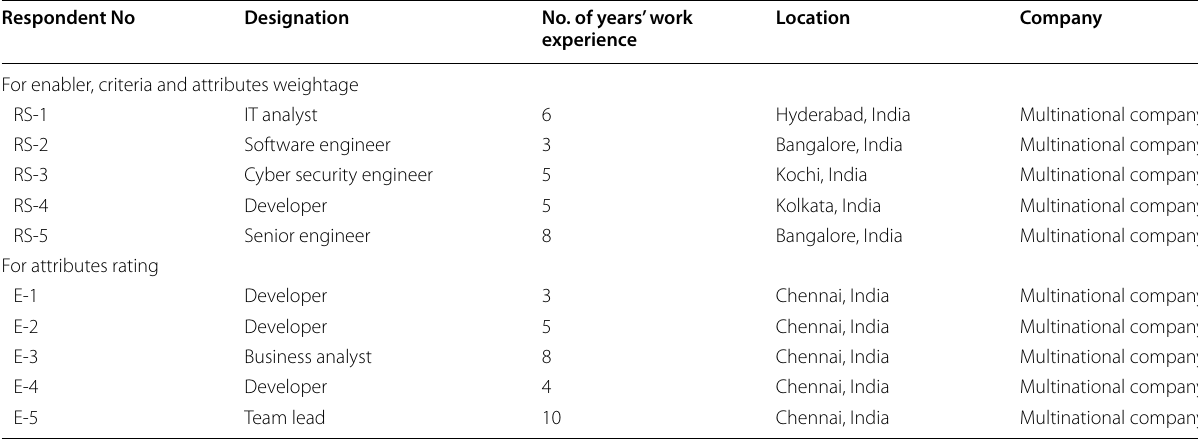
Table 2 Respondents